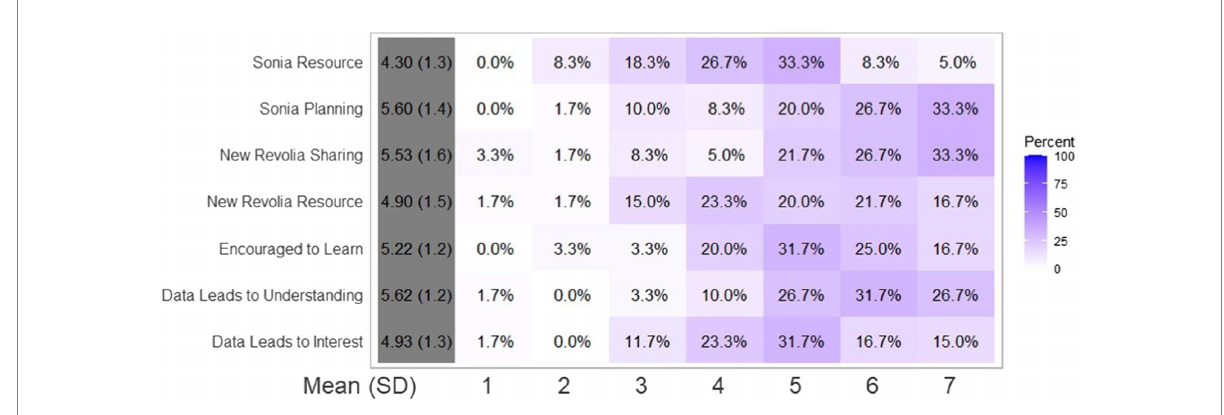
FIGURE 8 Quantitative results from survey on 1–7 Likert scale shown as heatmap to show the variation in the data. Questions same as in Figure 6.